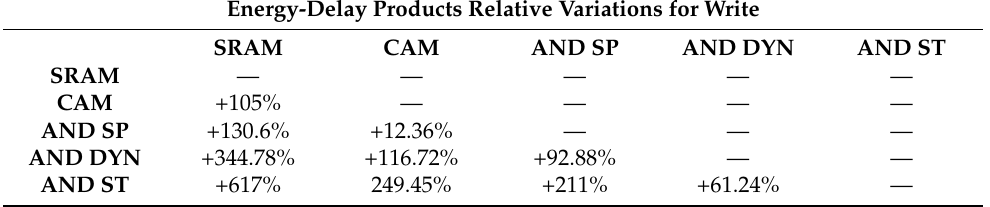
Table 5. Percentage differences in the write energy-delay products among the arrays. Each value corresponds to the increase, expressed in percentage, in the write energy-delay product of the memory on the corresponding row with respect to the one of the memory on the corresponding column. The data are extracted from Table 3.